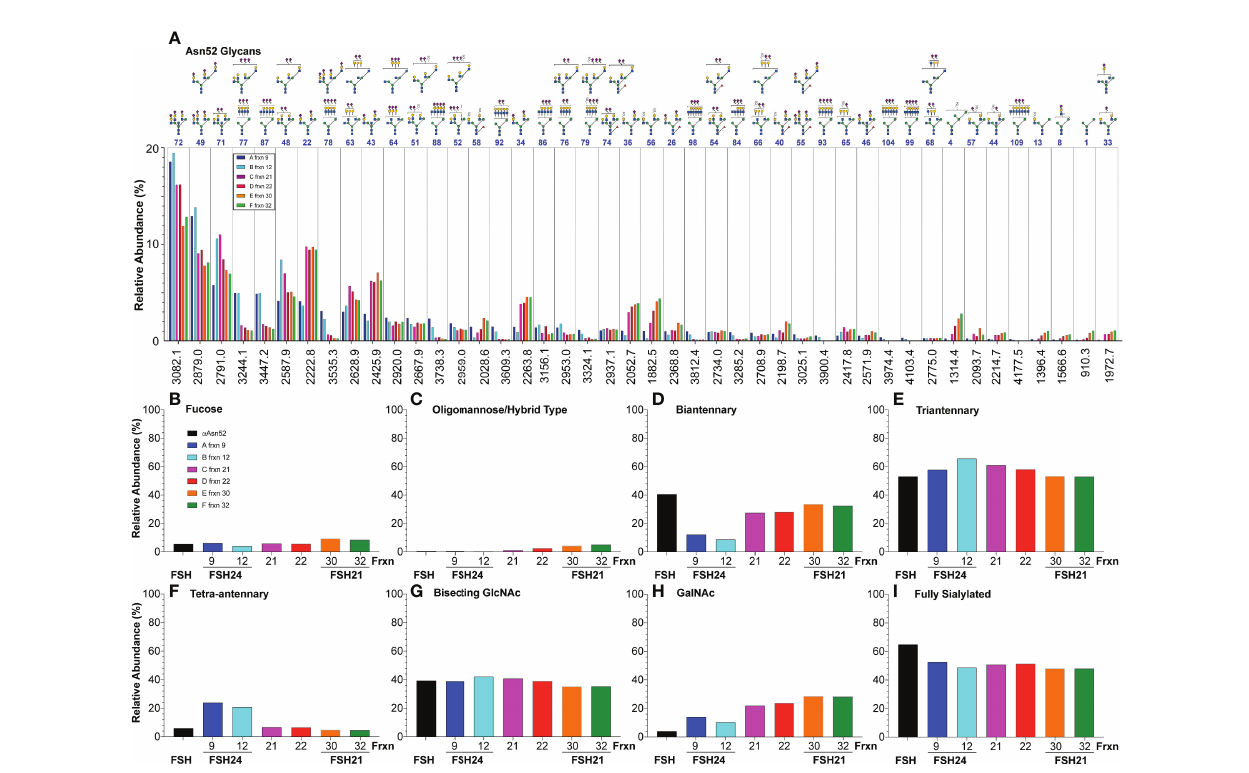
FIGURE 7 | Relative abundance of hFSH glycoform a Asn 52 oligosaccharide populations. FSH indicates FSH a Asn 52 glycan data (black bars) from Table 1 for comparison of products of conventional pituitary FSH puri fi cation with immunoaf fi nity puri fi cation. Fractions 9, 12, 21, 22, 30, and 32 are those recovered from the Superdex 75 chromatogram in Figure 4A . (A) Forty-four of 82 glycans ranked in order of fraction 9 glycan abundance. (B) Fraction of FSH a Asn 52 glycans possessing core fucose. (C) Oligomannose or hybrid type glycan abundance. (D) Biantennary glycan abundance. (E) Triantennary glycan abundance. (F) Tetra- antennary glycan abundance. (G) Glycans possessing bisecting GlcNAc residue. (H) Glycans possessing GalNAc residue substitution for Gal in complex antennae. (I) Glycans possessing suf fi cient Neu5Ac to cap all complex branches.